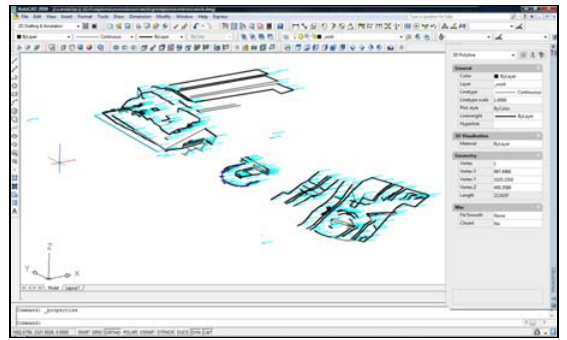
Figure 7. The three towers-sequence after completing the first phase of data processing (A).